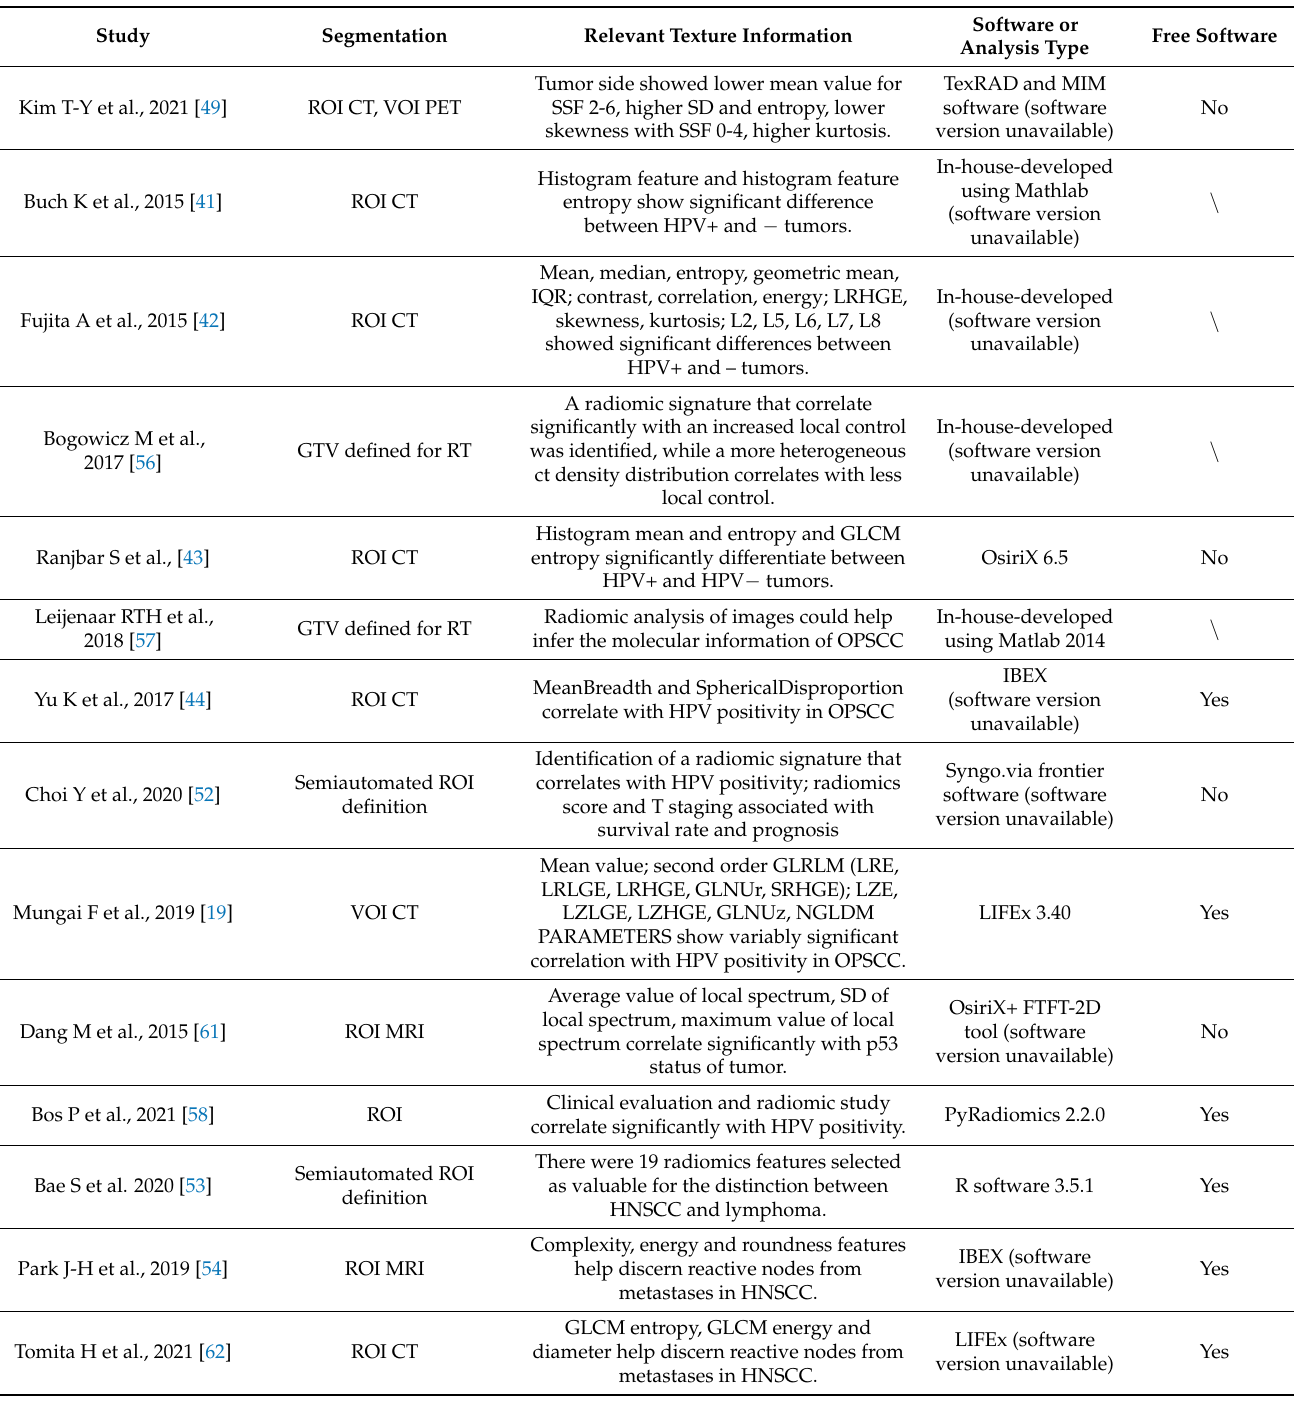
Table 3. Significant features and extraction methods. DSS: disease-specific survival; GLCM: grey level co-occurence matrix; GLNU: Gray level non-uniformity; GLRLM: Gray-level run-length matrix; IQR: interquartile range; LRE: long run emphasis; LRLGE/LRHGE: long-run low/high gray